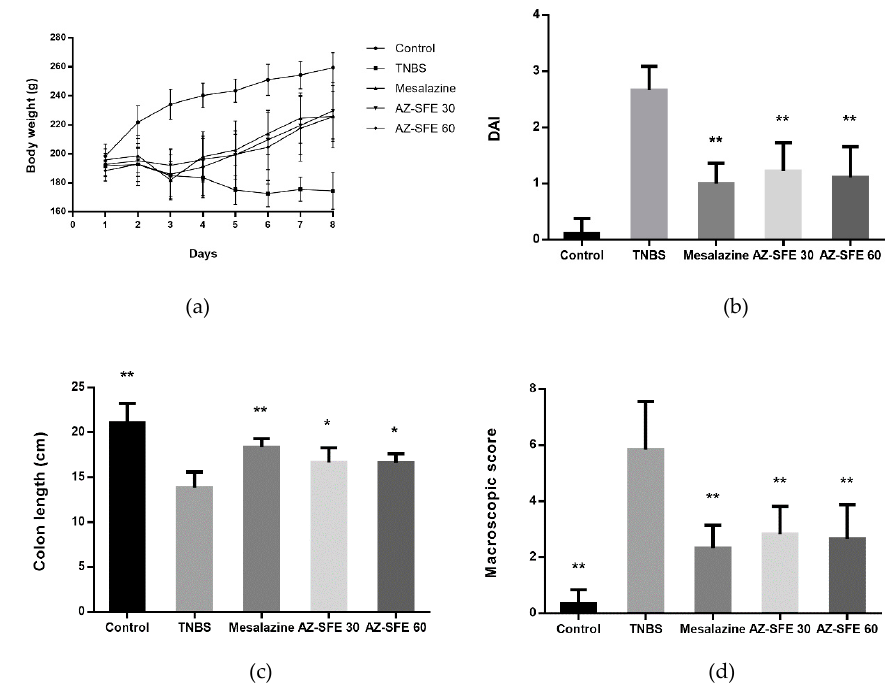
Figure 5. E ff ects of AZ-SFE (30 and 60 mg / kg) and mesalazine (400 mg / kg) on ( a ) body weight change, ( b ) disease activity index, ( c ) length of colons, and ( d ) macroscopic score of colons in TNBS-induced colitis rat model. Data are presented as mean ± SD of 6 rats per group. * p < 0.05, and ** p < 0.01 versus TNBS